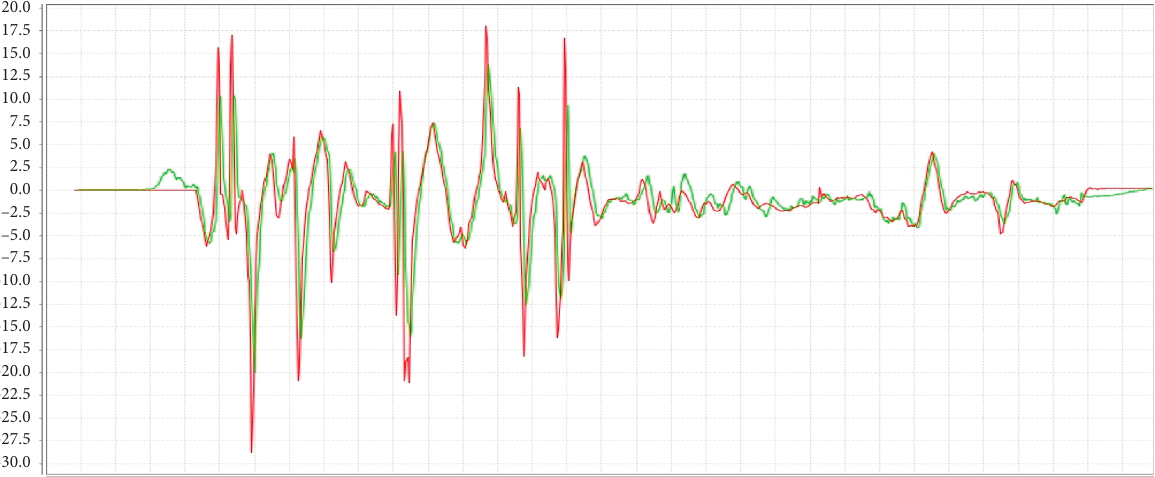
Figure 11: Actual flight roll angle graph.